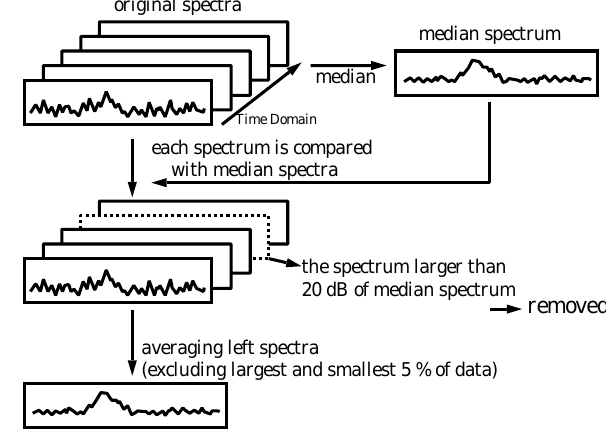
Fig. 1. The method of incoherent integration excluding contamina- tion by meteor